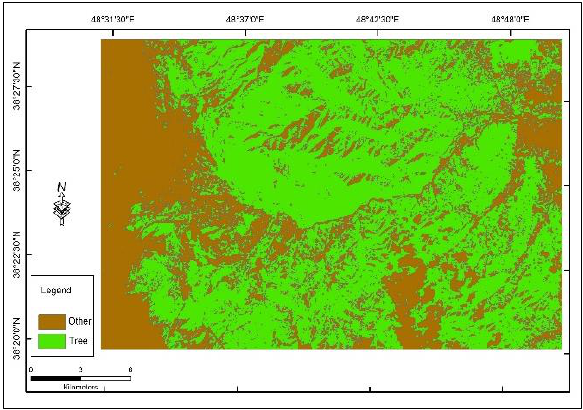
Figure 3 . Separation of tree class from pasture and others for 2021 (as an example).